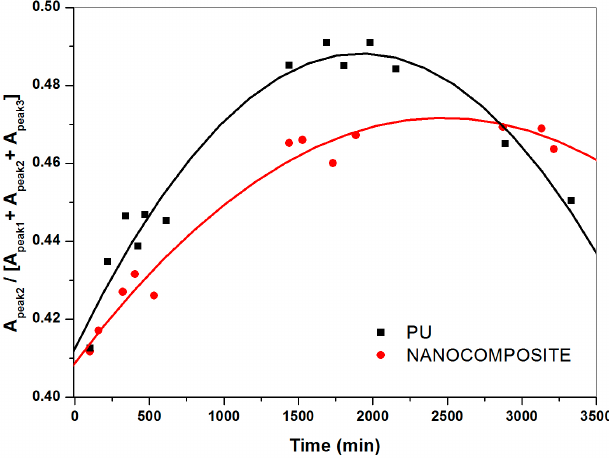
Figure 9. Relative fraction of strongly interacting water for plain (carbonate urethane) and TiO 2 /poly (carbonate urethane) nanocomposite against the time.